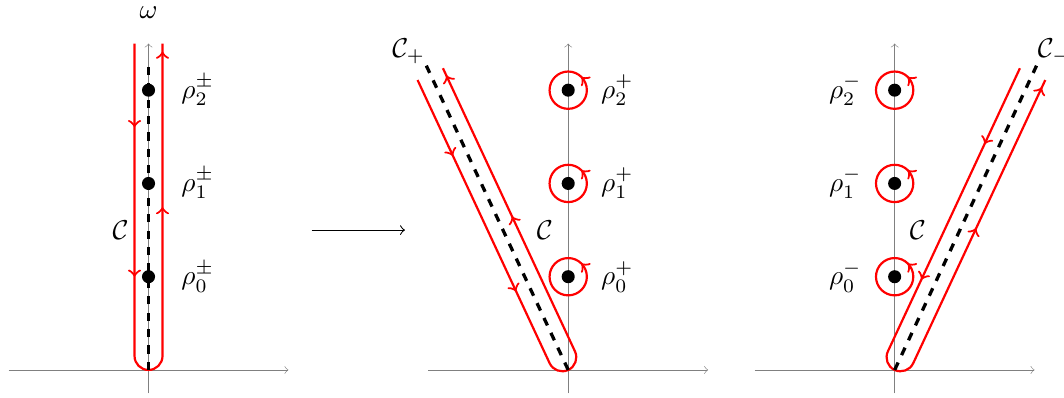
Figure 2 . The Hankel contour C can be deformed into an integral along the discontinuity of ρ ( ω ) , denoted by the dashed line, plus a sum over residues. However, due to the branch cut along the imaginary axis, this can be done in two different ways, which leads to two different integrations along the discontinuity, corresponding to the contours C ± . The residues of the poles ρ ± depend on this choice, as shown explicitly in